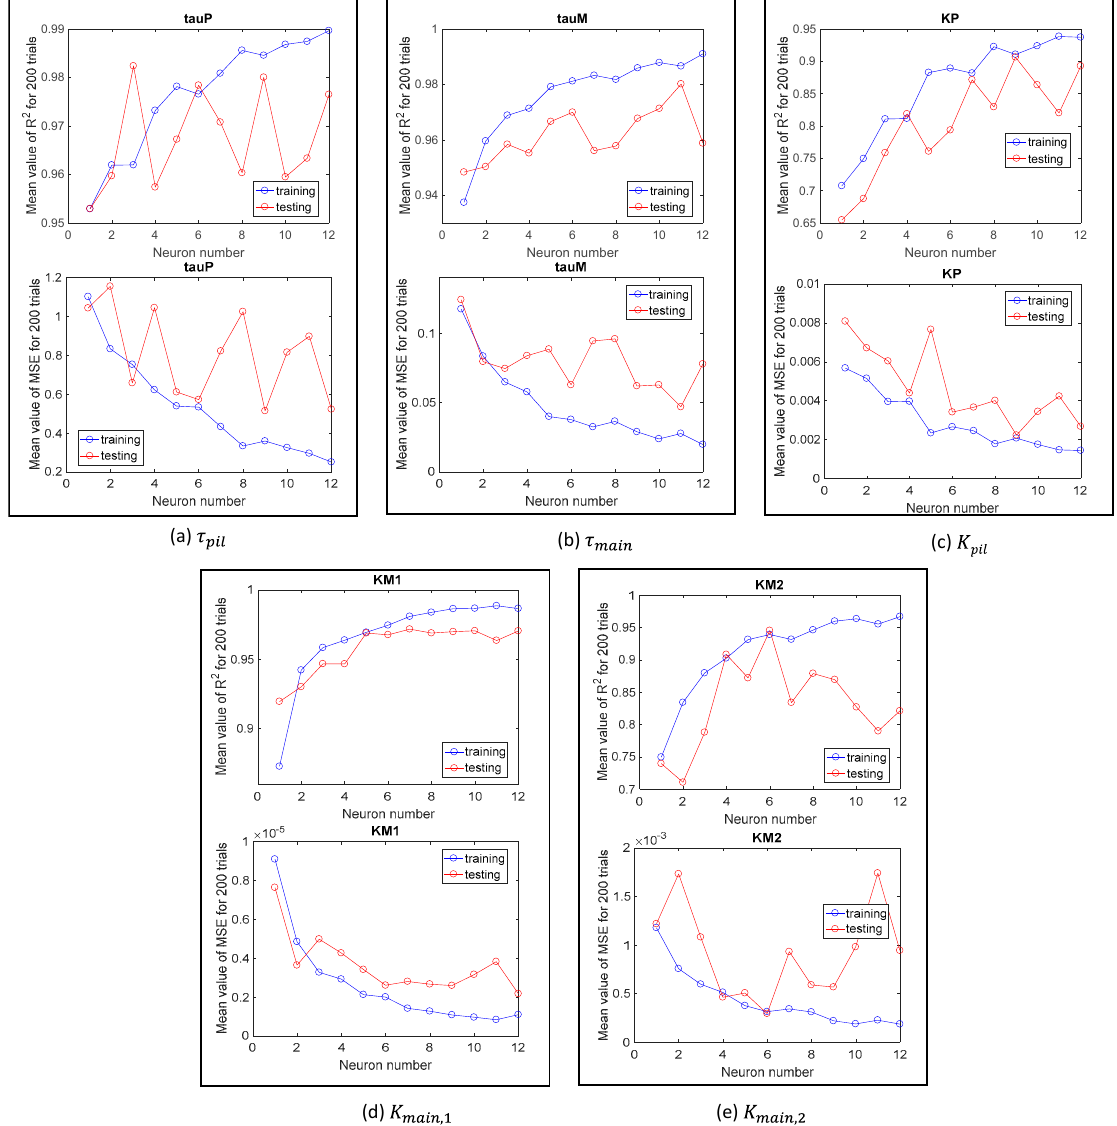
Figure A3. ( a – e ) Mean value of R 2 and MSE over 200 training trials for the ANNs that simulate the di ff erent parameters of the physics-based model (heat release simulation), as a function of the number of